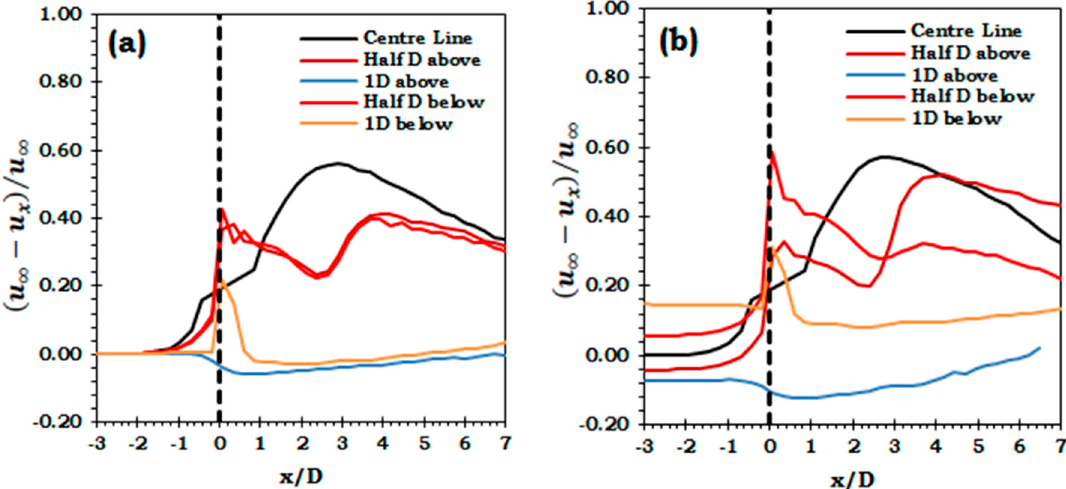
Figure 12. Velocity deficit along the length of the channel at different channel depths for ( a ) uniform velocity; ( b ) velocity profile.